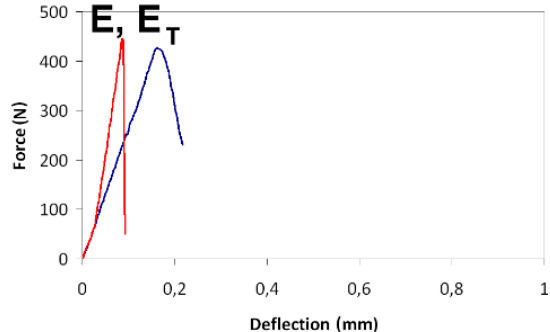
Figure 10. Typical load-deflection curves of the tested FCB compositions. The blue curves show the behavior of the specimen in an as-delivered state and the red curves show the behavior of the specimens with the carbonized reinforcing